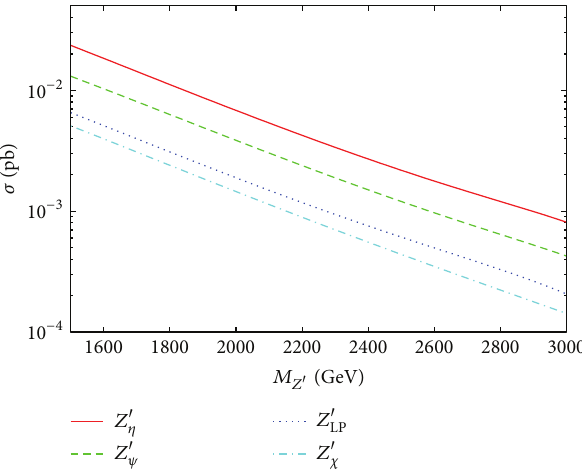
Figure 10: The cross sections for 𝑝𝑝 → (𝑡 󸀠 𝑡 + 𝑡 󸀠 𝑡) + 𝑋 versus the 𝑍 󸀠